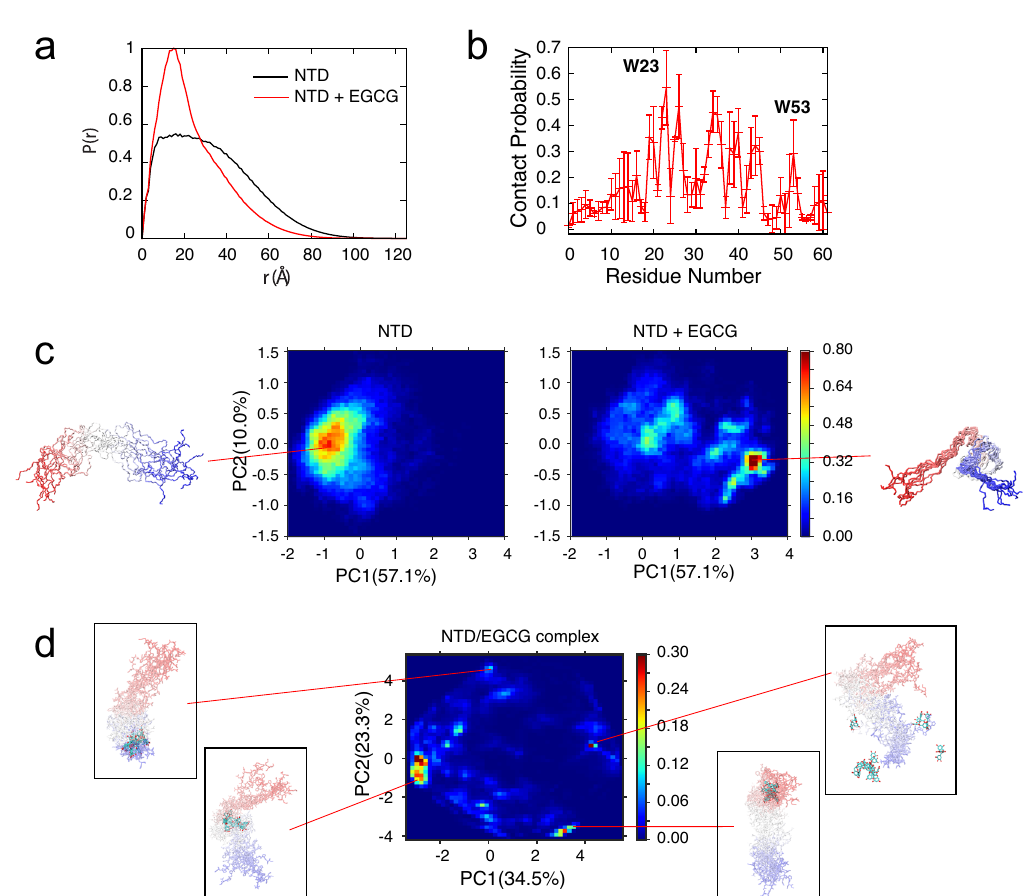
Fig. 4 EGCG-induced conformational changes of NTD and EGCG – NTD complexes derived from atomistic simulations. a Pairwise distance distributions in the presence or absence of EGCG molecules calculated from REST2 simulations. b Probability of contacts between EGCG and each residue of p53 – NTD. A contact was de fi ned as those with minimal heavy atom distance ≤ 4.2 Å. The contact probability was presented as the mean and standard deviation (error bars) of three subtrajectories ( n = 3). Source data are provided as a Source Data fi le. c Probability distribution of simulated disordered ensembles of NTD projected onto the fi rst two principal components (PCs) in PCA analysis in the absence (left) or presence (right) of EGCG. Values in the parenthesis are percentages of variance along each direction. Ten representative structures for the most populated basin of each state are shown, with a color gradient from red at the N-terminus to blue at the C-terminus. d Probability distribution of the NTD/EGCG complex structures projected onto the fi rst two PCs in PCA analysis. Representative structures for a few highly populated basins are shown, with the bound EGCG represented in (0.6 μ M). We further validated the inhibition effect of EGCG by fl